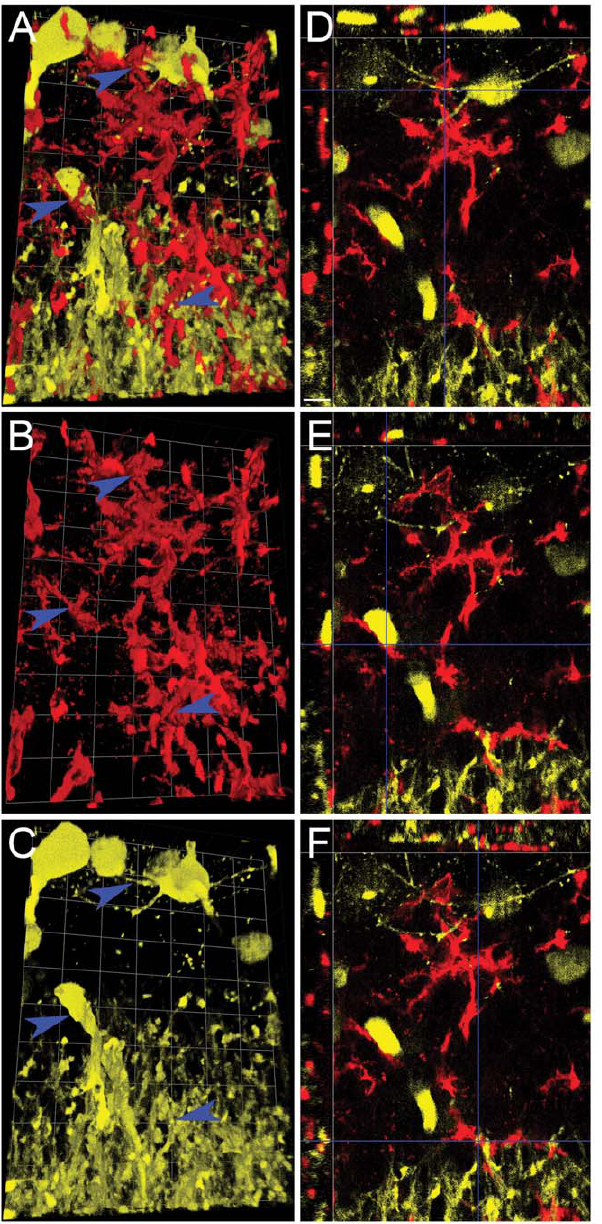
Figure 8. Stereotactic injection of saline control does not induce engulfment of dendrites. Montage of 3D reconstruction micrographs of a representative tissue section from right hippocampus of YFP H mice that received saline control vehicle and were sacrificed 24 hours later (n=3 replicates). Panels A–C depict a 3D reconstruction of CD11b + microglia (red) interacting with YFP + pyramidal neurons (yellow), while Panels D–F show XYZ views at different depths in the same image stack. Blue arrowheads point to cell-to-cell contact between microglia and neuronal processes. These points of contact are illustrated in the XYZ view in Panels D and F (crossing point of the two blue cursor lines). Panel E shows an XYZ view of a neuronal soma contacting a microglial process (crossing point of the two blue cursor lines). Each side of the individual grid=14 m m in Panels A, B, and C, and the scale bar in Panel D=16 m m for Panels D–F.